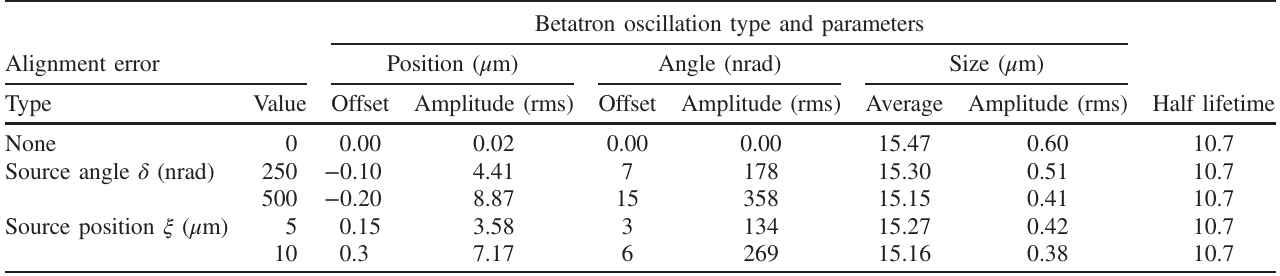
TABLE VI. X-ray beam characteristics at the source position simulated for a cavity with yaw angle alignment error δ or lateral spatial error ξ at the source as derived from the data in Figs. 19 –